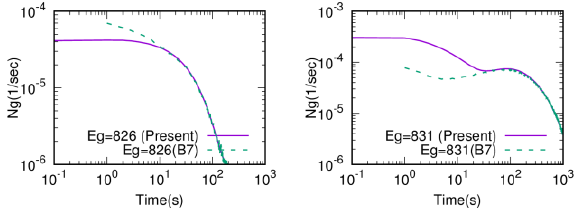
Fig. 4 Calculated BDFGs at E  =826 and 831 keV compared with those in ENDF/B-VII.1 for n th + 235 U fission.